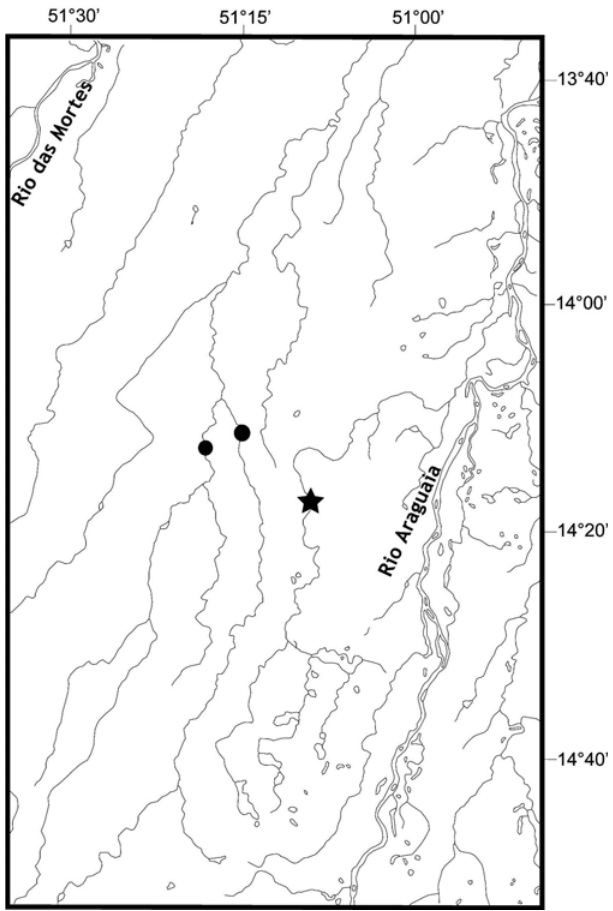
Fig. 10. Hydrographic map showing geographic distribution of the Ituglanis macunaima . Symbols: star, holotype; circles, paratypes.